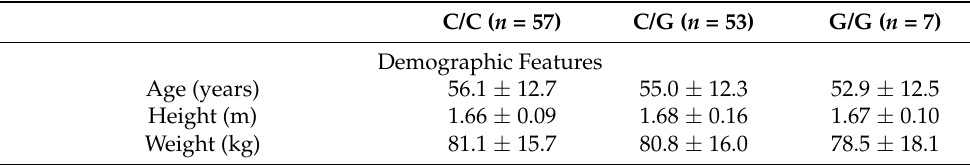
Table 6. Differences in clinical, sensory-related, cognitive and psychological variables in individuals with post-COVID pain depending on the 5-hydroxytryptamine receptor 1B gene ( HTR1B ) Val287 polymorphism ( rs6296